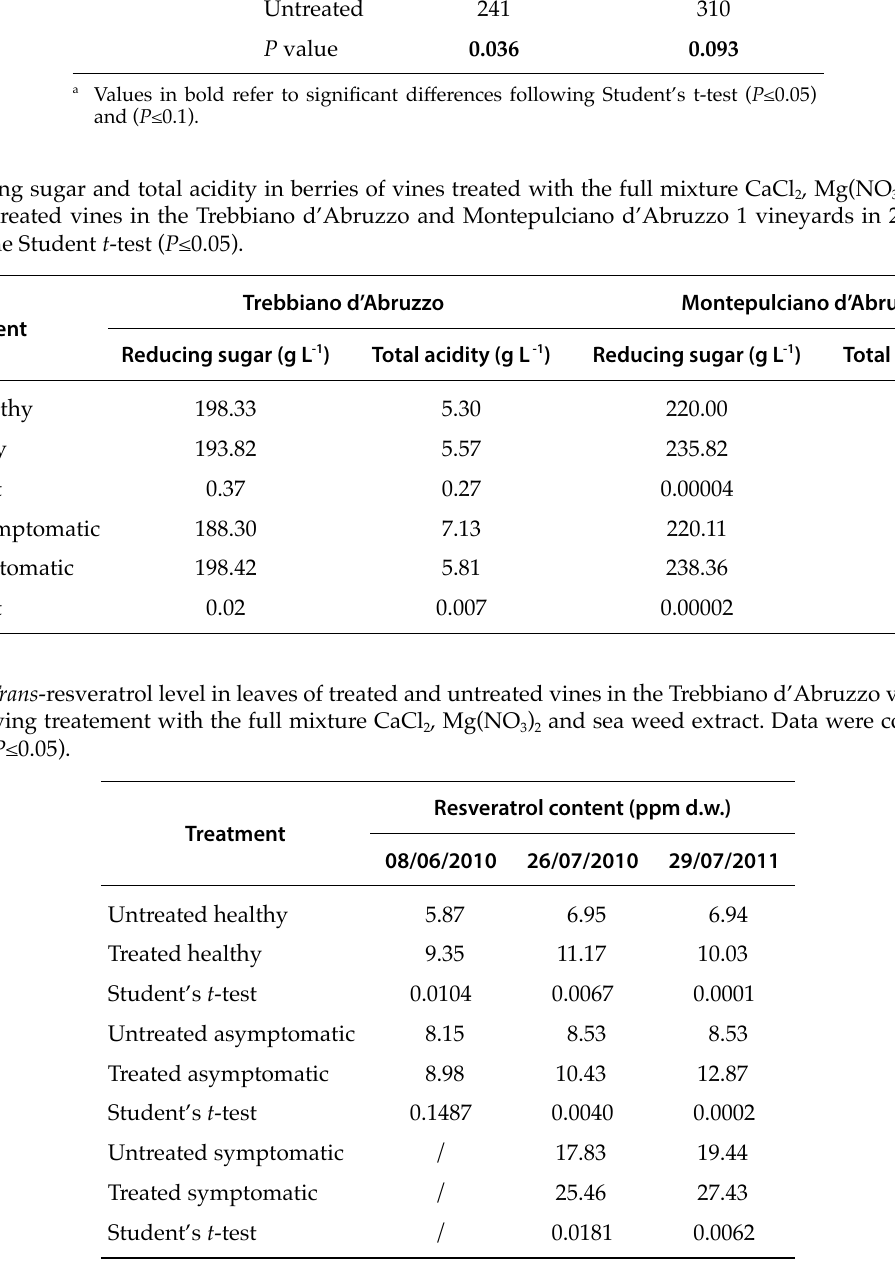
2 , Mg(NO 3 ) 2 and seaweed